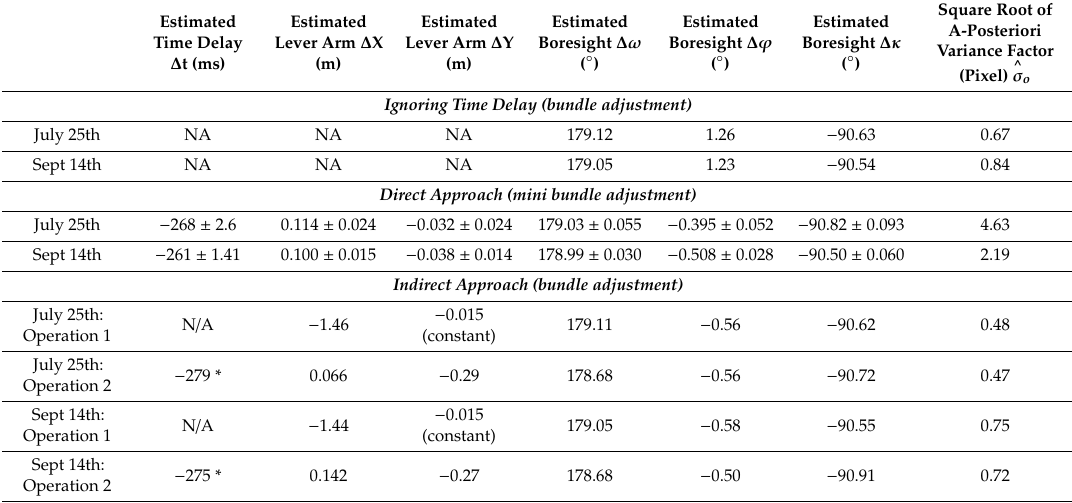
Table 5. Estimated parameter results for the DJI M200 thermal platform, including the standard deviation for direct results.